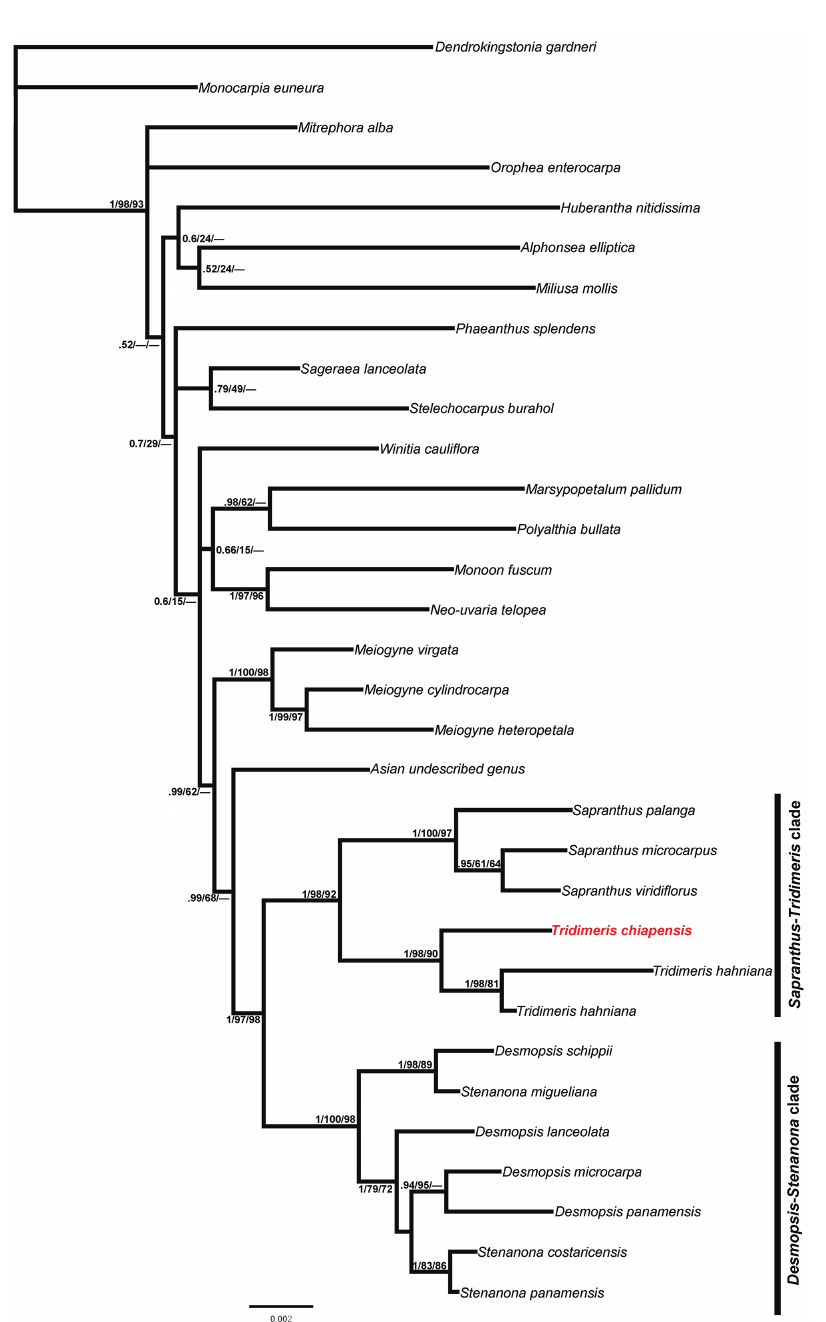
Figure 2. The 50% majority-rule consensus tree from the Bayesian analysis of six cpDNA markers. Numbers on branches of the major clades indicate Bayesian posterior probabilities (PP), maximum likeli- hood (MLBS) and parsimony (MPBS) bootstrap values in that order. In red, the position of Tridimeris chiapensis Escobar-Castellanos &